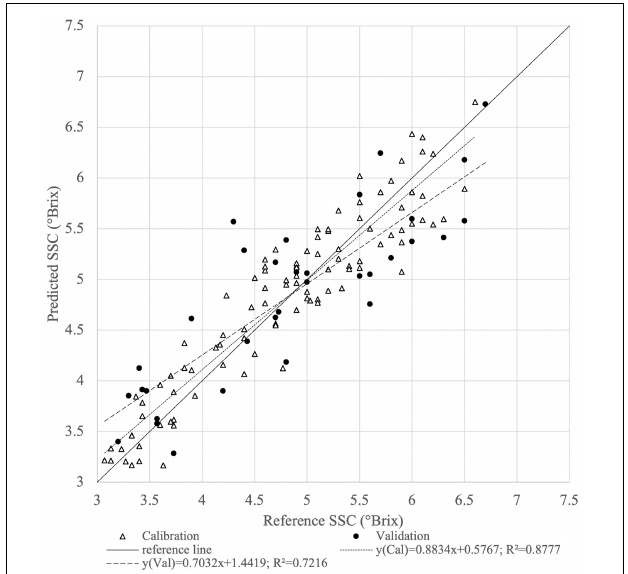
FIGURE 8 | Calibration (Cal) and validation (Val) set of reference ( n = 144) vs. predicted ( n = 48) lycopene content of homogenized tomato fruit samples derived from the best PLSR model from absorbance of Vis-NIR spectra.